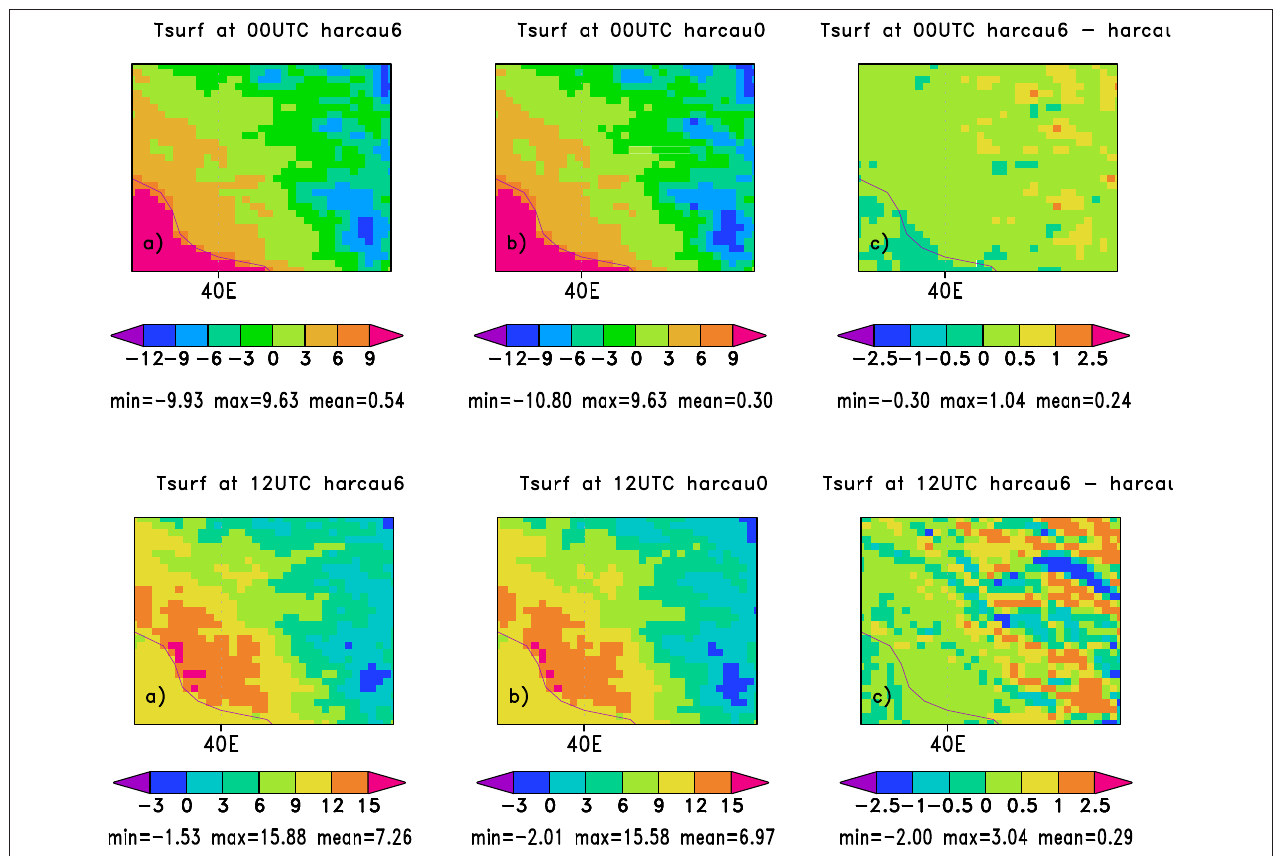
FIGURE 9 | Monthly average nighttime (upper panel) and daytime T s (lower panel), unit: ◦ C as given by the 00 UTC + 24 h (night) and 12 UTC + 24 h (day) forecasts, otherwise as for Figure 8.